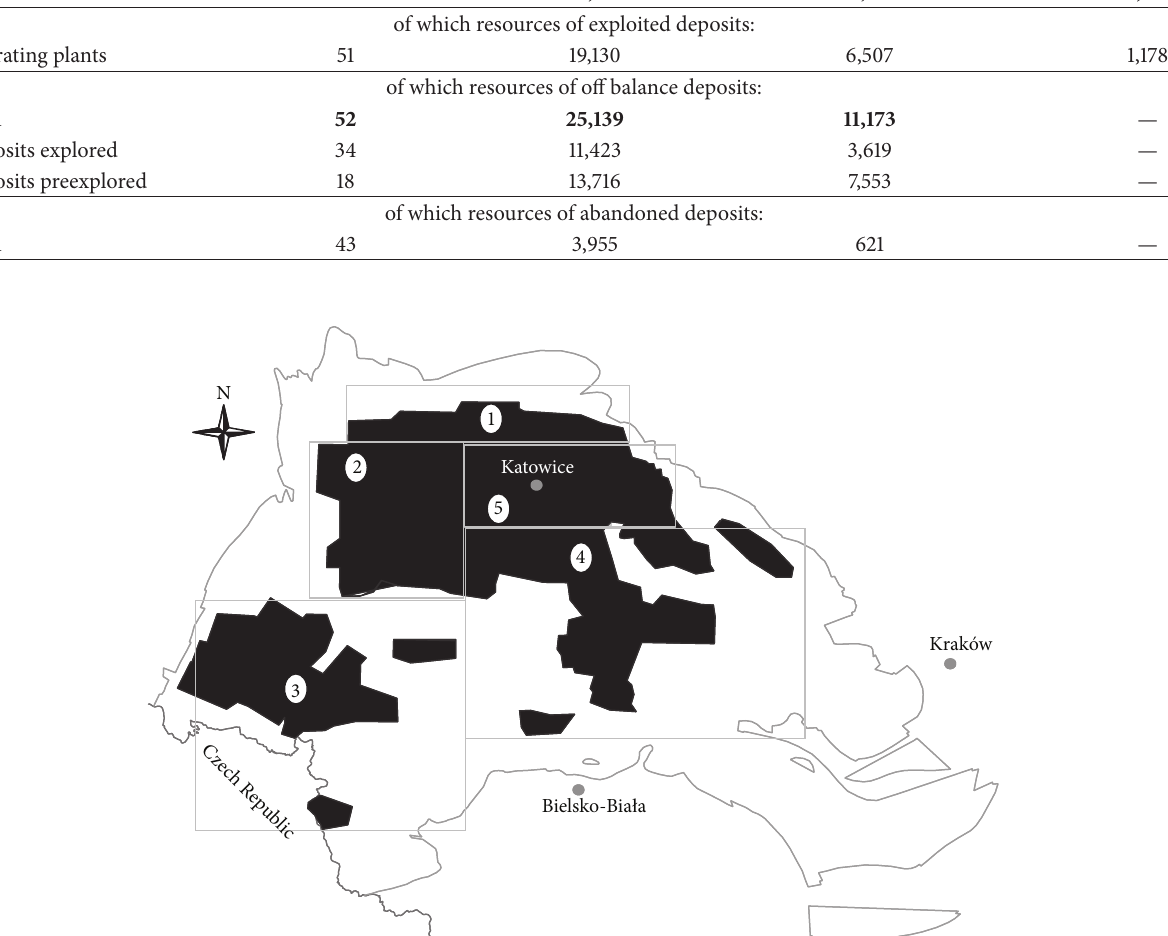
Figure 3: Division of the explored area: 1—north zone, 2—west zone, 3—south zone, 4—east zone, and 5—central